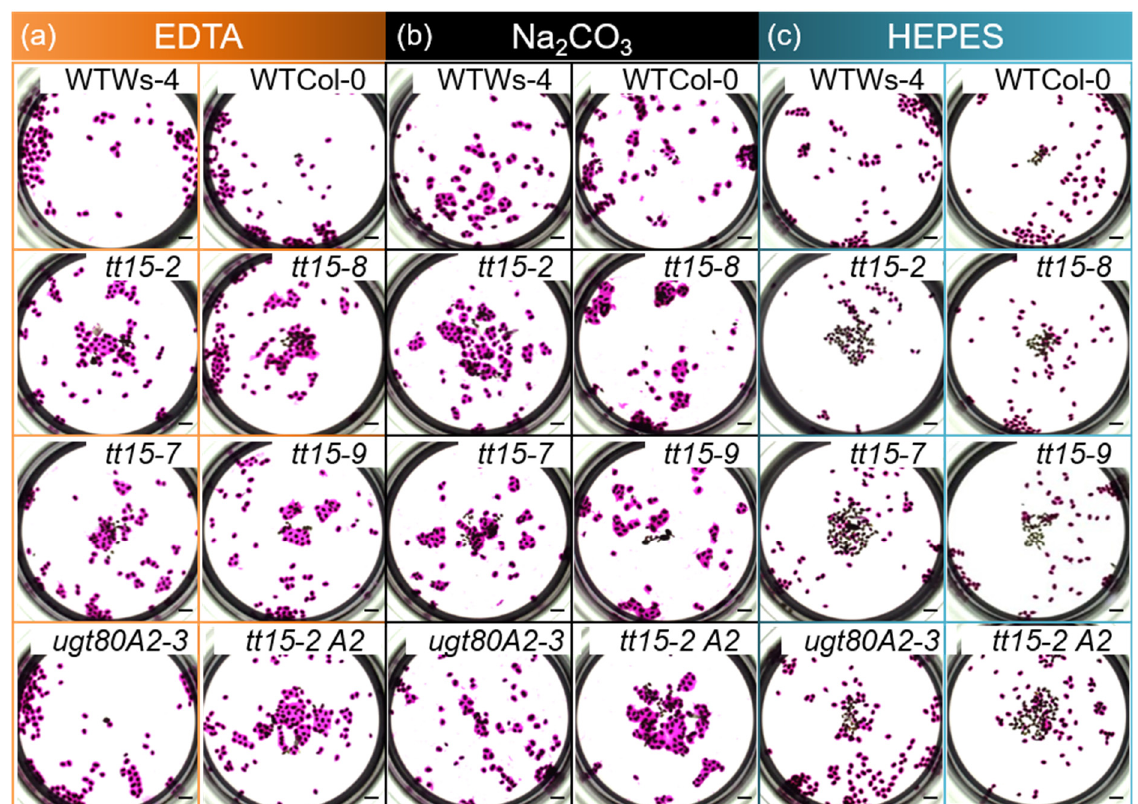
Figure 2. The mucilage release defect in tt15 mutants is complemented by imbibition in EDTA or Na 2 CO 3 , but not the HEPES buffer. Batches of 100 seeds per genotype were imbibed in ( a ) 50 mM EDTA pH 8.0 (images outlined in orange) ( b ) 1 M Na 2 CO 3 (images outlined in black) or ( c ) 50 mM HEPES pH 8.0 (images outlined in blue) followed by ruthenium red staining. Wild-type, WT; tt15-2 ugt80A2-3 , tt15-2 A2 . Bars = 1 mm. Similar results were obtained with seed batches from 3 biological replicates/genotype.